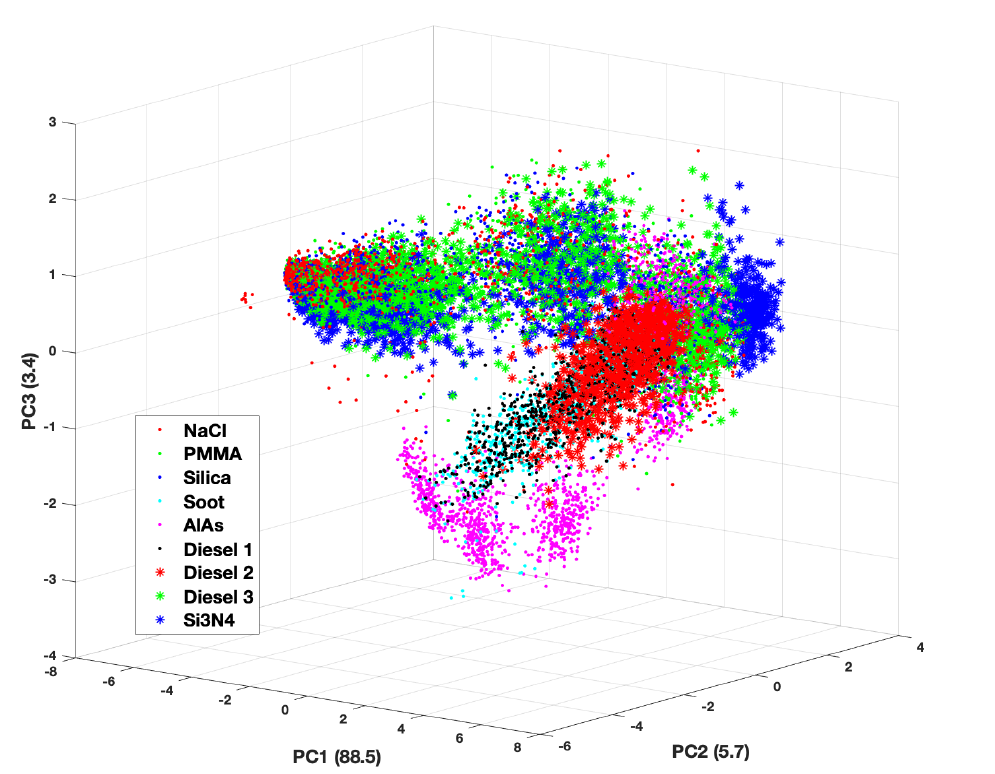
Figure 7. Three-dimensional plot of the scores values for first 3 principal components of the forward scattering dataset by cluster